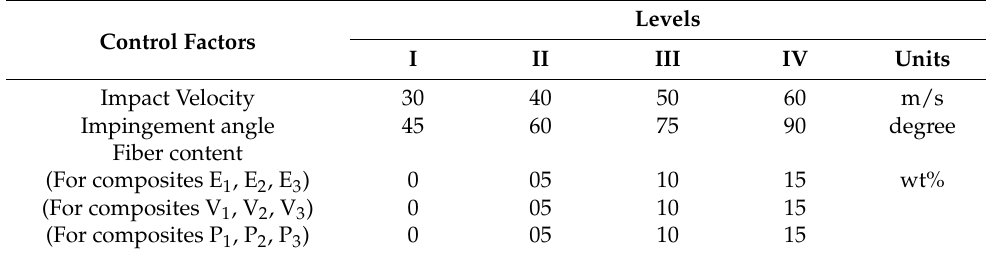
Table 2. Control factors and respective levels.